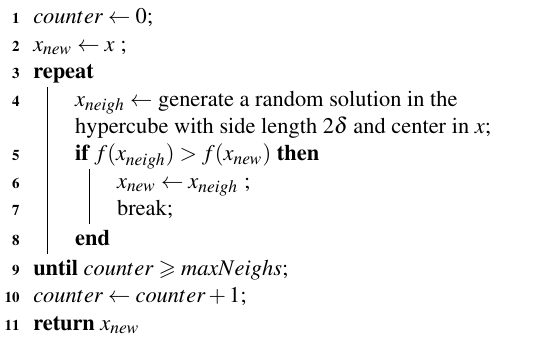
Algorithm 1: exploreNeighbourhood( x , δ , maxNeighs